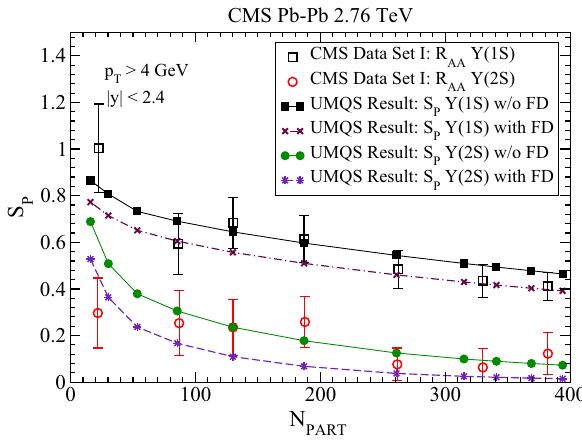
Fig. 14 Double ratio versus centrality corresponding to CMS Data Set √ I is compared with ϒ( 2 S ) to ϒ( 1 S ) yield ratio s NN = 2 . 76